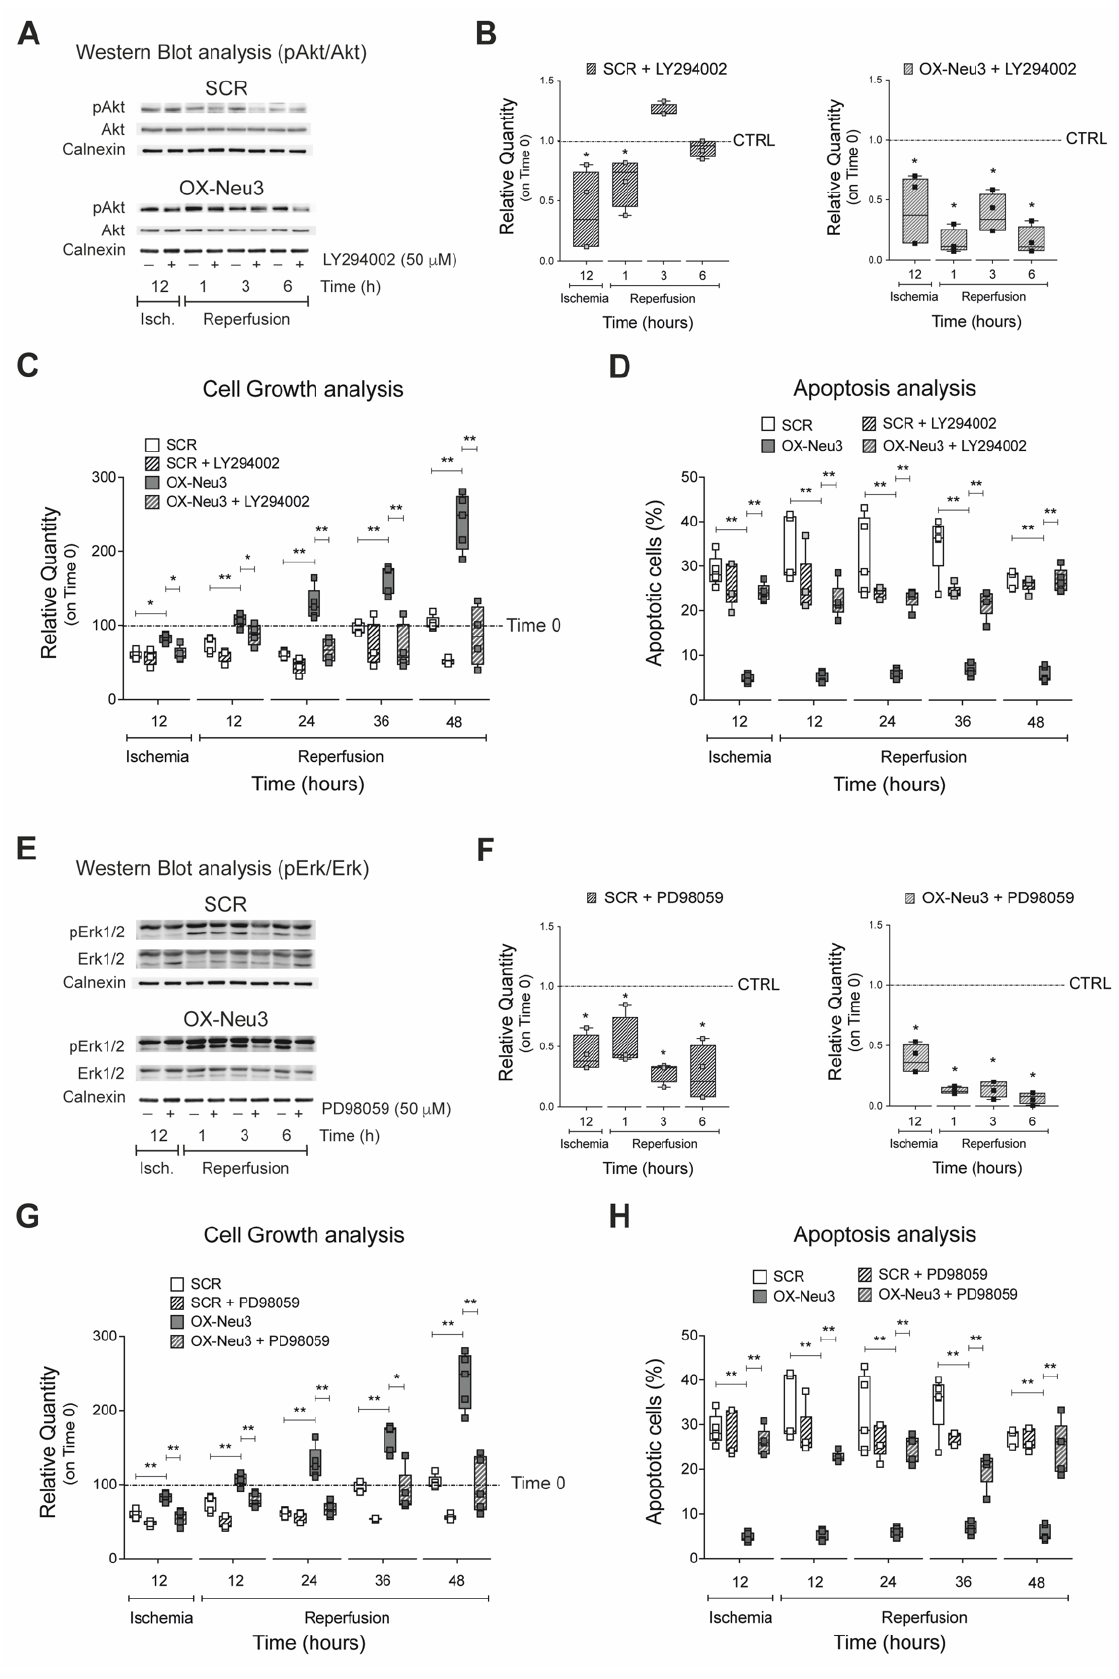
Figure 8. Effects of the RISK pathway inhibition on the sialidase-3 mediated cardioprotective effects. ( A ) WB analysis of phospho-Akt (Thr308) and total-Akt in scramble and OX-Neu3 cells treated with LY294002. Calnexin was used as a housekeeper to normalize protein expression; ( B ) ratio between phospho-Akt (Thr308) and total-Akt. The levels of Akt activation, at each time point analyzed, have been expressed as relative quantity using either LY294002-untreated SCR or OX- Neu3 cells exposed to IRI in vitro as internal reference control ( CTRL dashed line ); ( C ) analysis of cell growth of scramble and OX-Neu3 cells treated with LY294002 and exposed to IRI. Data are expressed as relative quantity (%) compared to either SCR or OX-Neu3 cells at the beginning of IRI exposure ( Time 0 dashed line ); ( D ) analysis of apoptosis level of scramble and OX-Neu3 cells treated with LY294002 and exposed to IRI. Results are expressed as percentage of apoptotic nuclei per total nuclei; ( E ) WB analysis of phospho-Erk1/2 (Thr202/Tyr204) and total Erk1/2 in both